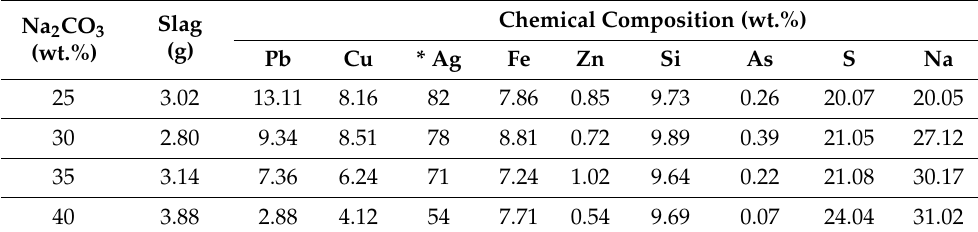
Table 3. Chemical composition and weight of the slags obtained after the reduction process with different amounts of Na 2 CO 3 (25, 30, 35, and 40 wt.%), and 0.4 g of SiC to 1000 ◦ C. Chemical Composition (wt.%) Slag Na 2 CO 3 (g) (wt.%) Pb Cu * Ag Fe Zn